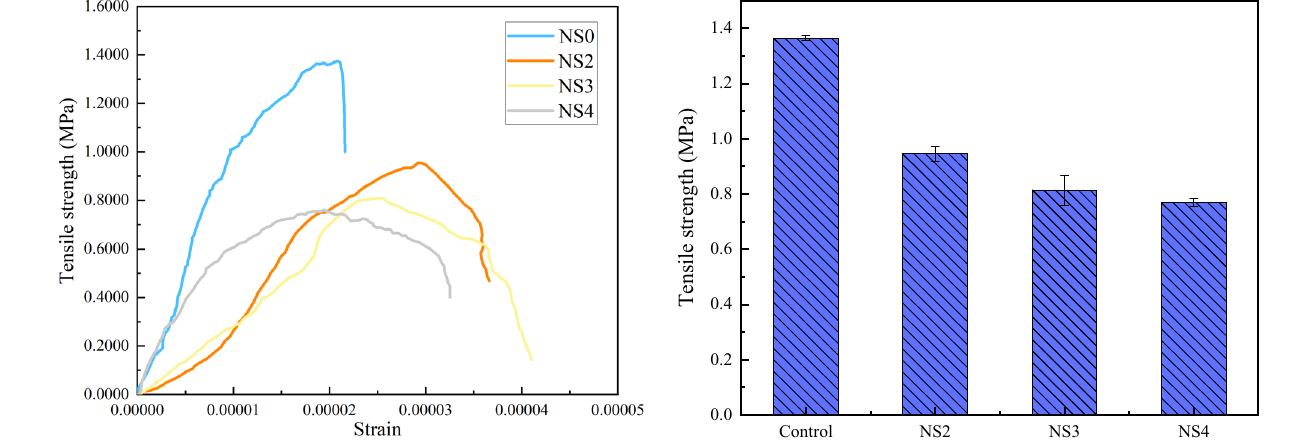
Figure 10: Typical stress - strain curves of geopolymers with nano - SiO 2 [ 87 ] .